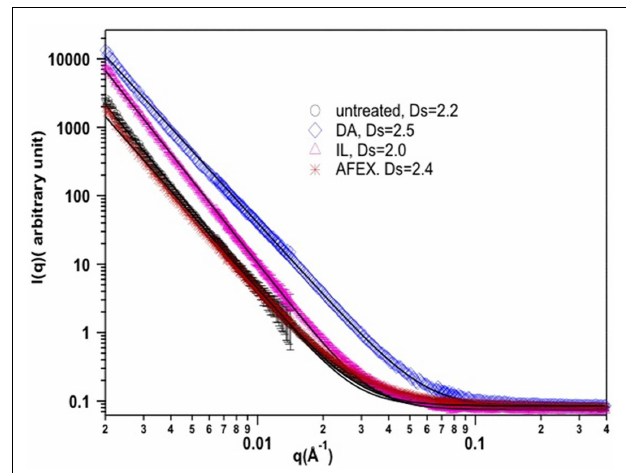
FIGURE 2 | SANS spectrum of corn stover samples before and after pretreatment . D S refers to surface fractal dimension.